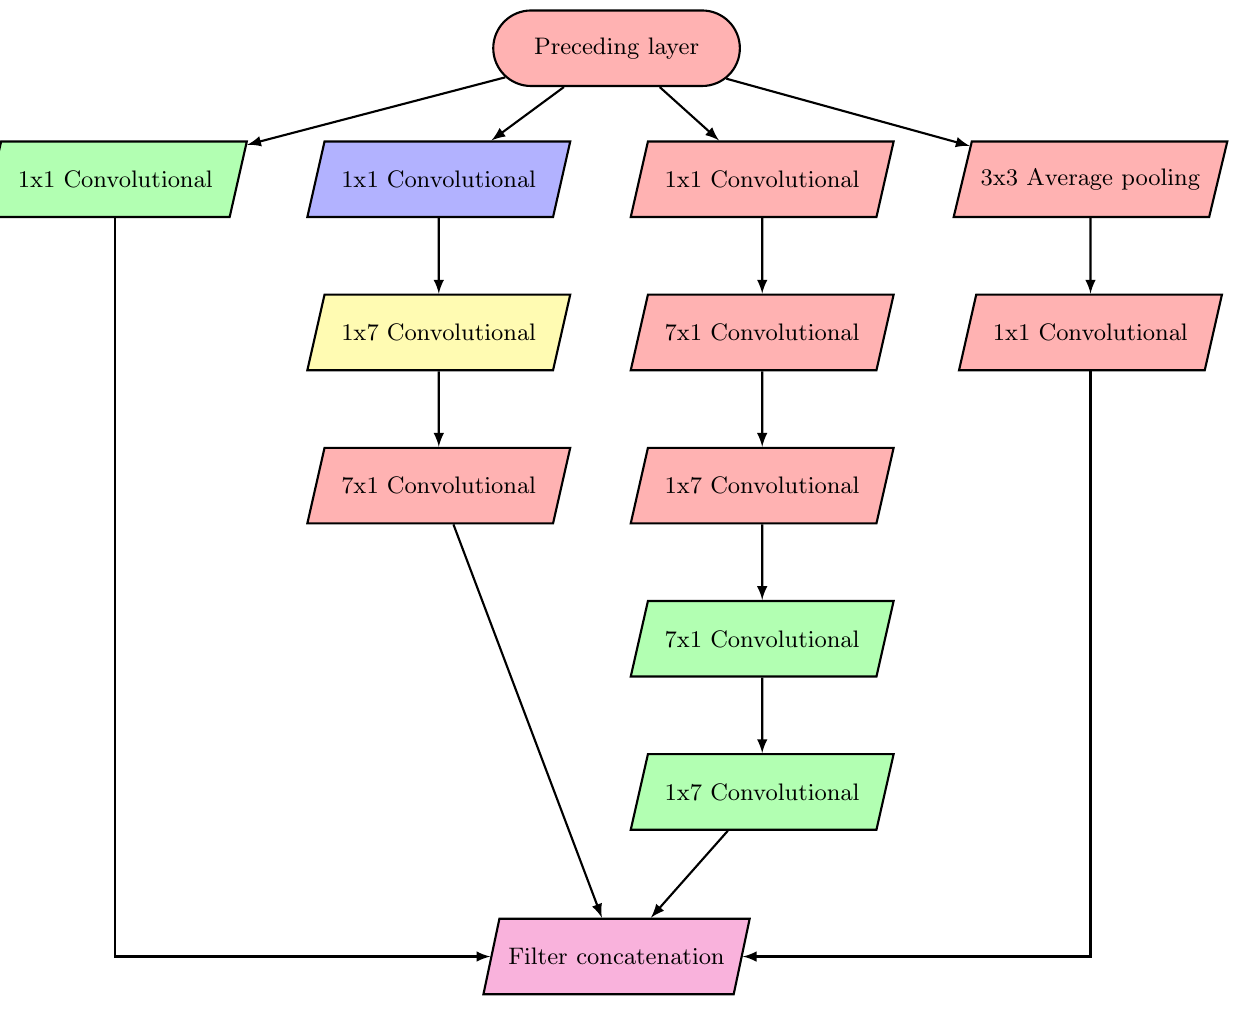
Figure 1. Block diagram of Inception